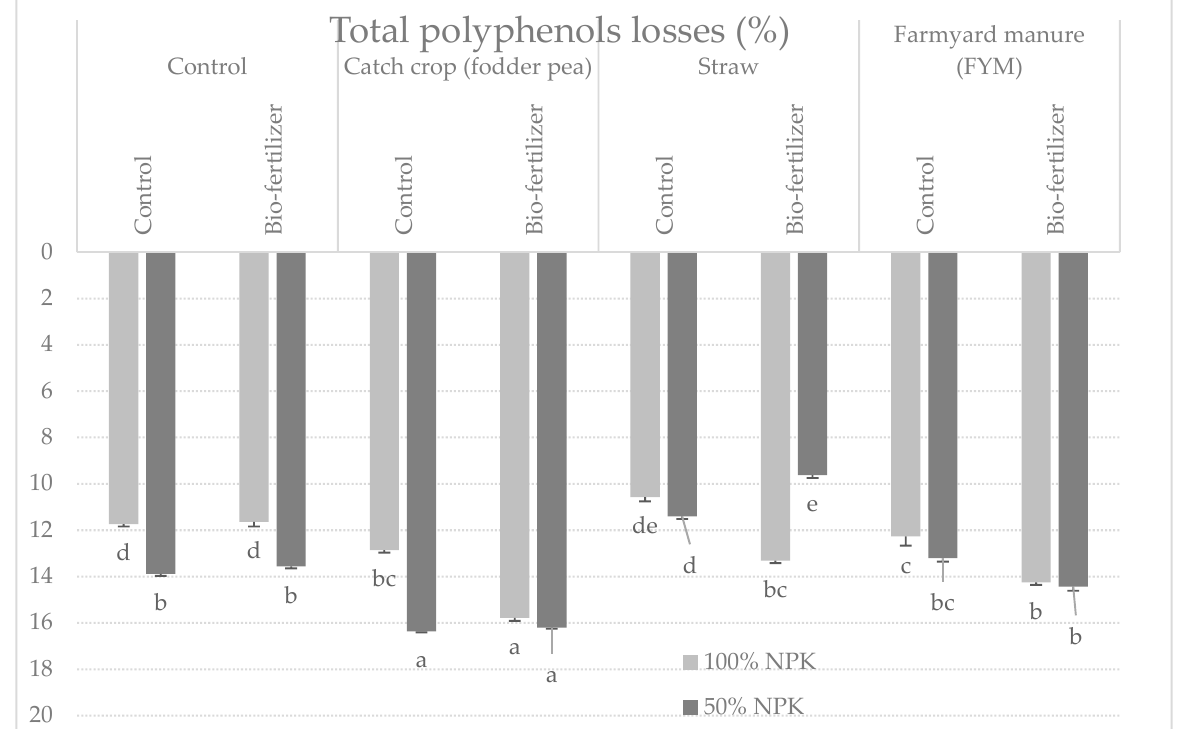
Figure 2. Percentage changes in total polyphenols content in potato tubers after 6 months of storage depending on the tested factors (mean from 3 years storage seasons). a, b, c, d…: means noted with the same letter are not significantly different ( p < 0.05).